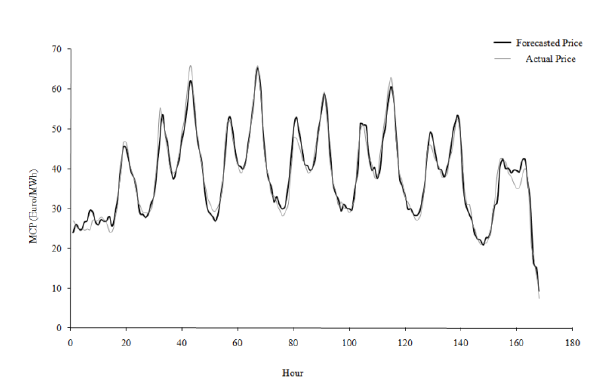
Figure 9 . Forecasted MCP for second week in October (Indian market in the year 2019)